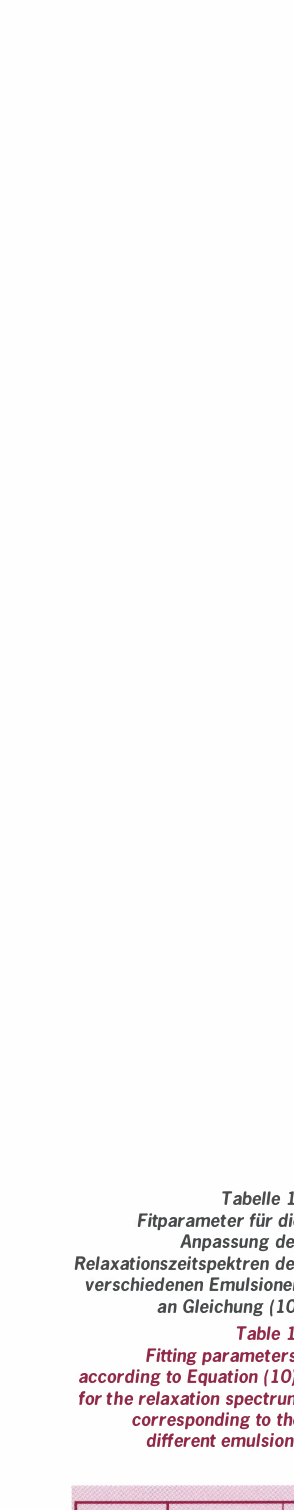
Fig. 1: Experimental and recalculated values of the storage and loss moduli for the emulsion 5